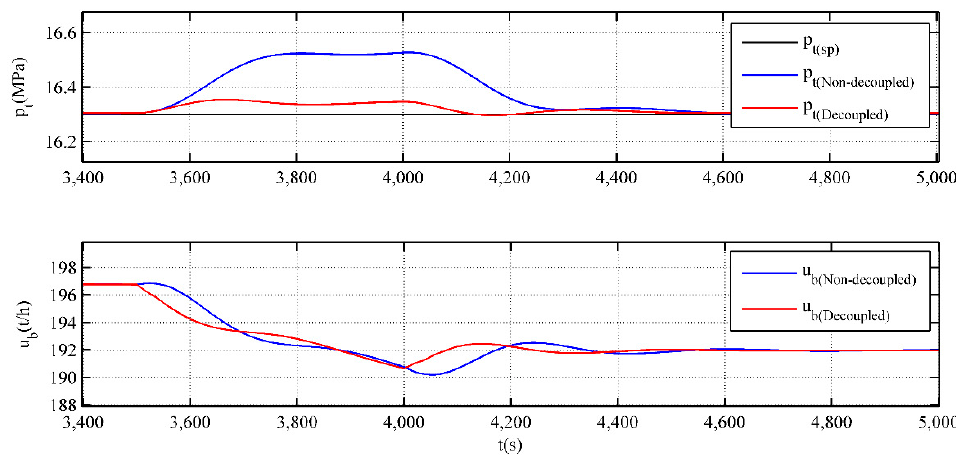
Figure 7. Amplification curves of p t and u b .